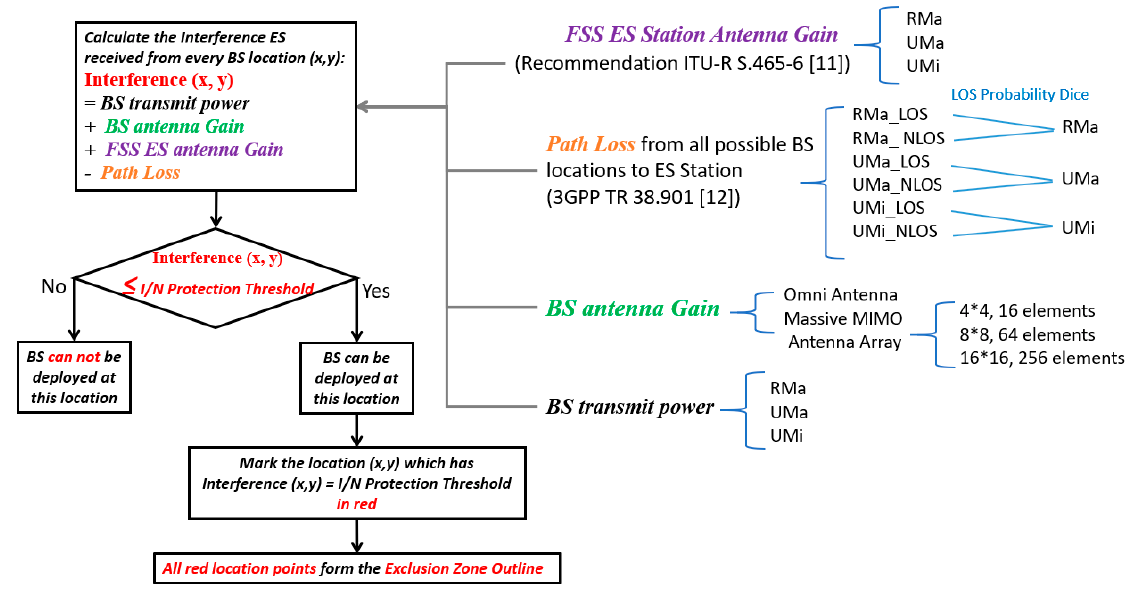
Figure 7. Flowchart of the distance protection method: Exclusion zone.